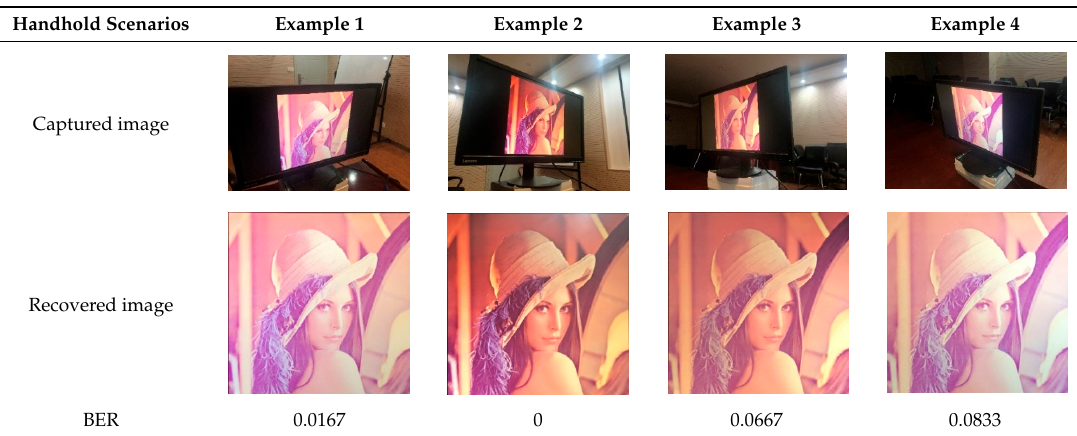
Table 5. Examples of Handhold Shooting.